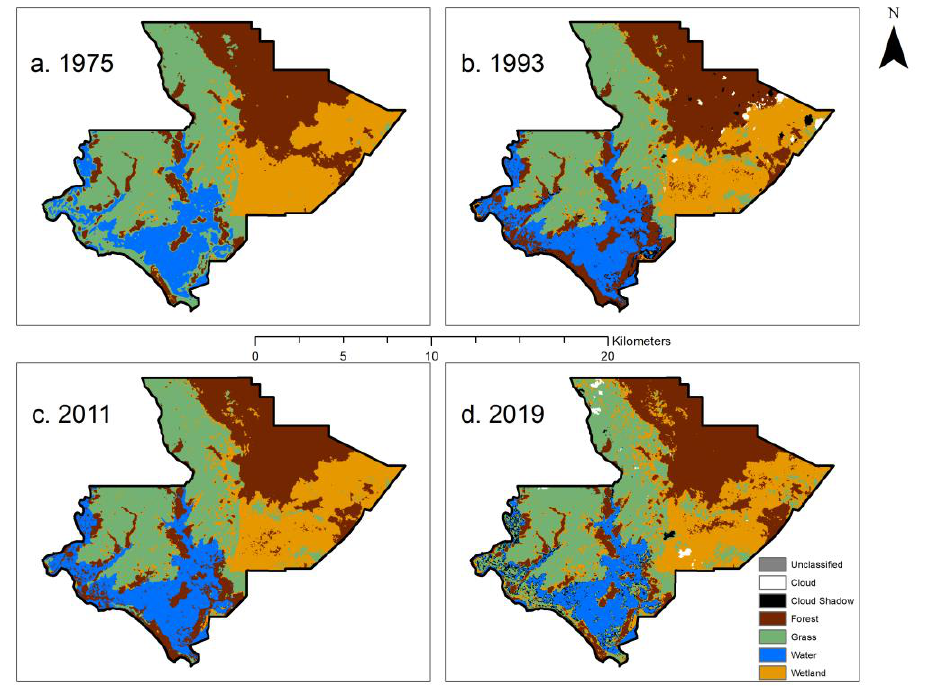
Figure 4. Support Vector Machine classification results based on Landsat imagery and other data for: ( a ) 1975; ( b ) 1993; ( c ) 2011; ( d ) 2019.